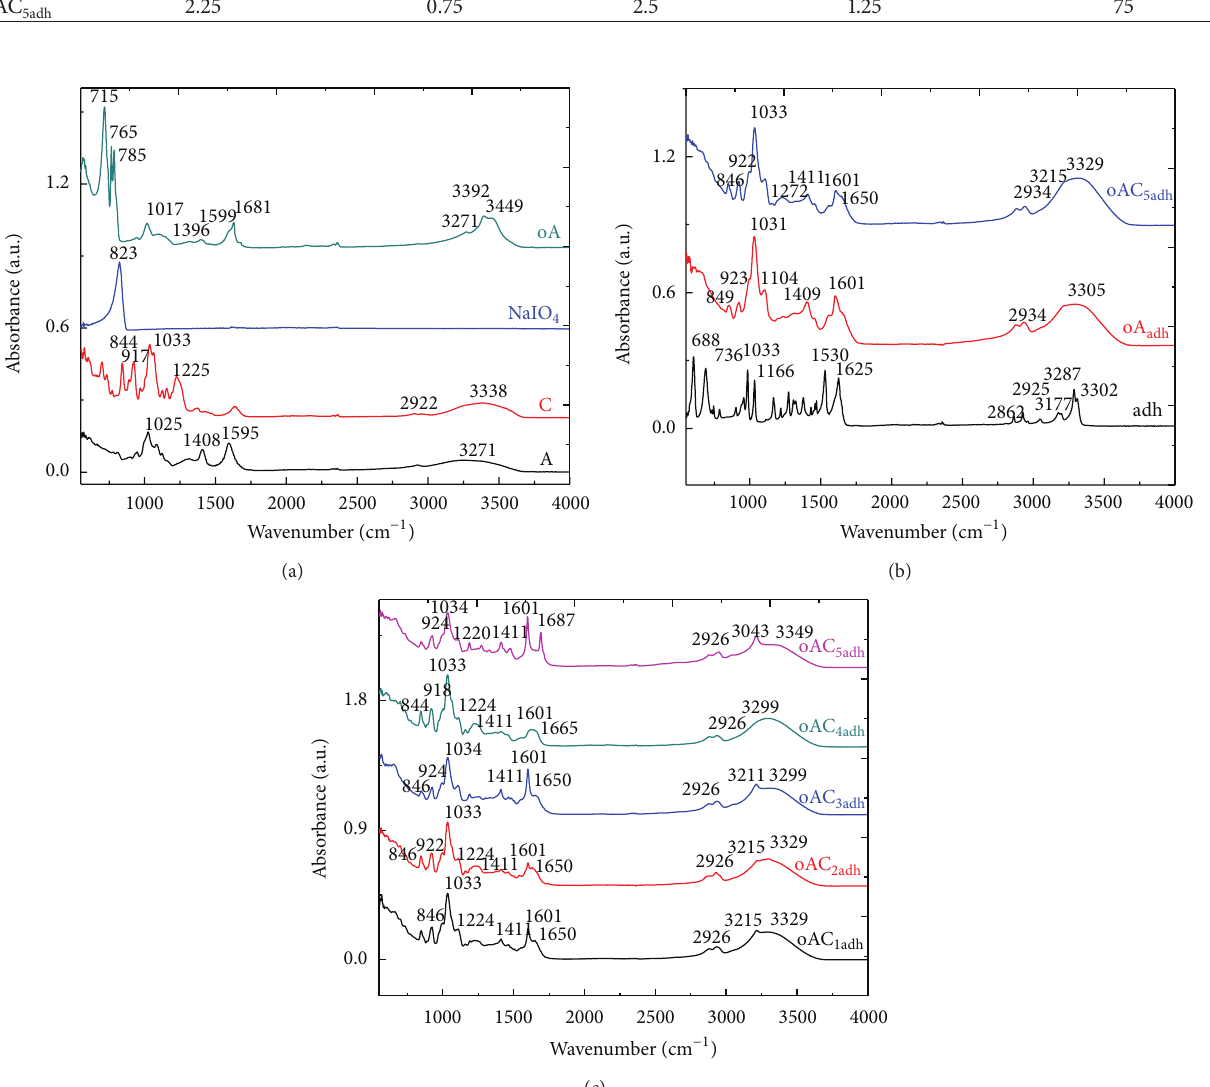
Figure 1: IR spectra of (a) pure alginate (A) and k-carrageenan (C), sodium metaperiodate (NaIO 4 ), and oxidized alginate (oA); (b) adipic dihydrazide (adh), hydrogel film of oxidized alginate cross-linked with adipic dihydrazide (oA adh ), and cross-linked oxidized alginate/k- carrageenan composite hydrogel film (oAC 5adh ); (c) all formulations of cross-linked oxidized alginate/k-carrageenan composite hydrogels films (oAC 1adh –oAC 5adh